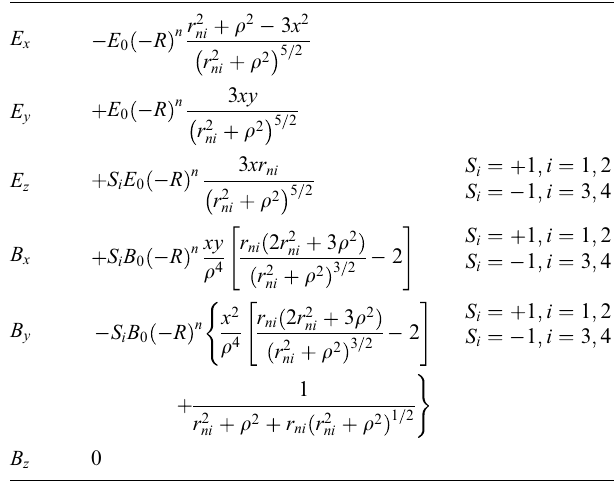
Table 2. Layer-2 secondary field terms for the HED